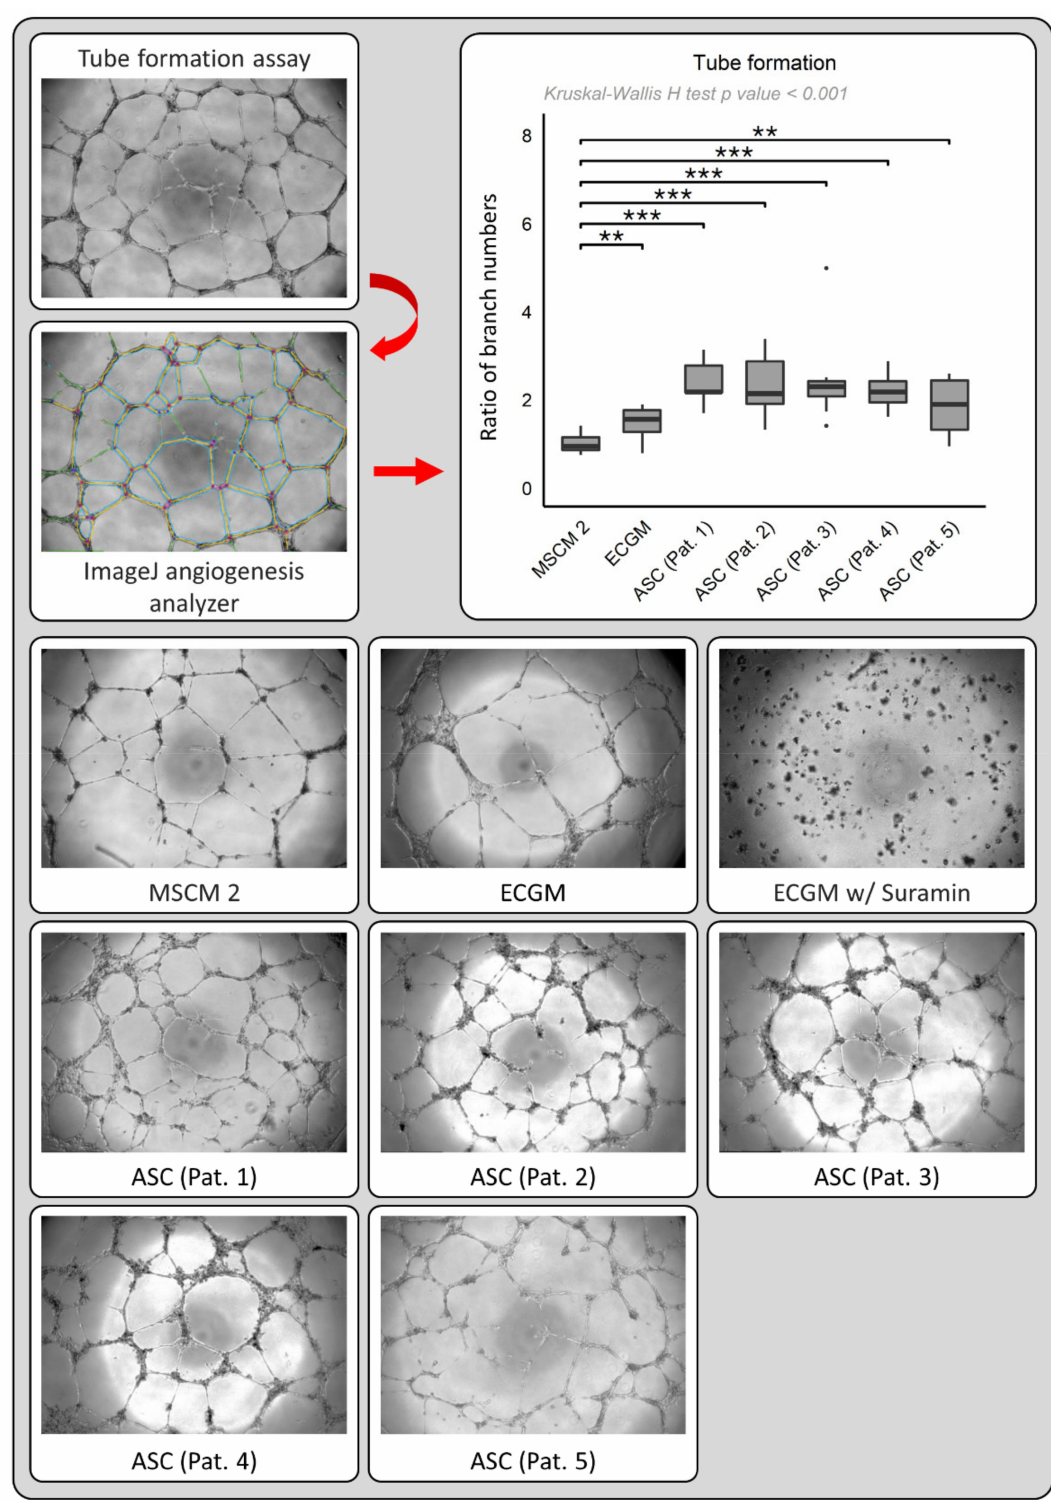
Figure 4. Top left: Branches (yellow lines) in each well were counted using ImageJ Angiogenesis Analyzer software. Top right: Box-whisker plots depicting tube formation (number of branches normalized to MSCM 2 control after subtraction of ECGM with 30 nM Suramin control) of HUVECs cultured with the MSCM 2 control, ECGM (without Suramin) control, or ASC-derived supernatants from five different patients (“ASC (Pat. 1–5)”). Lower half: Representative photographs depicting tube formation in wells corresponding to patients 1–5 (“ASC (Pat. 1–5)”) and controls. p -values ** < 0.01, *** <